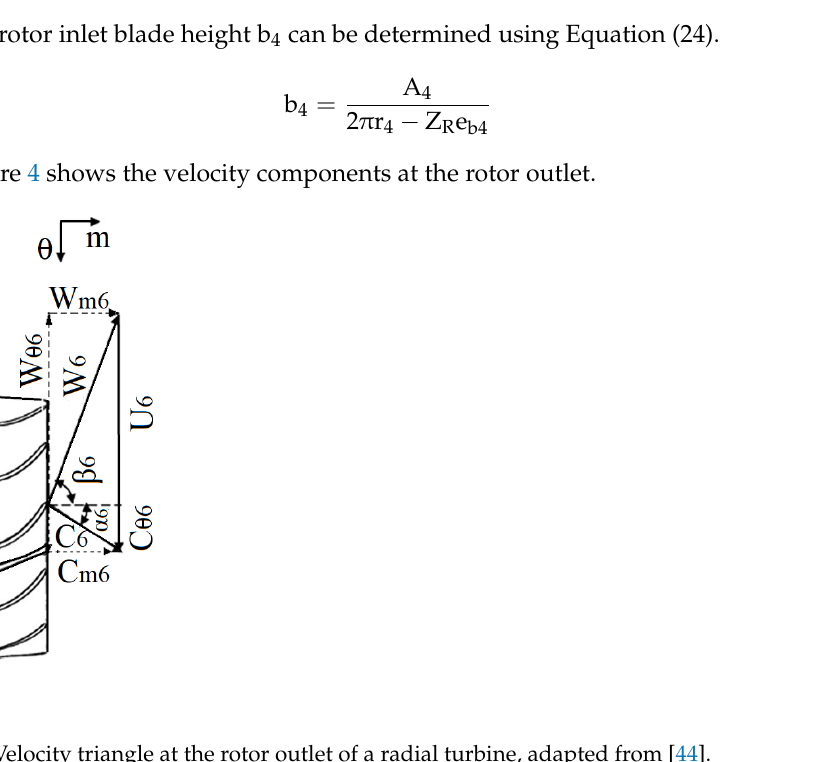
Figure 4. Velocity triangle at the rotor outlet of a radial turbine, adapted from [44]. The value of the circumferential rotation speed at the rotor outlet (cid:4666) U (cid:2874) (cid:4667) is determined using Equation (25).